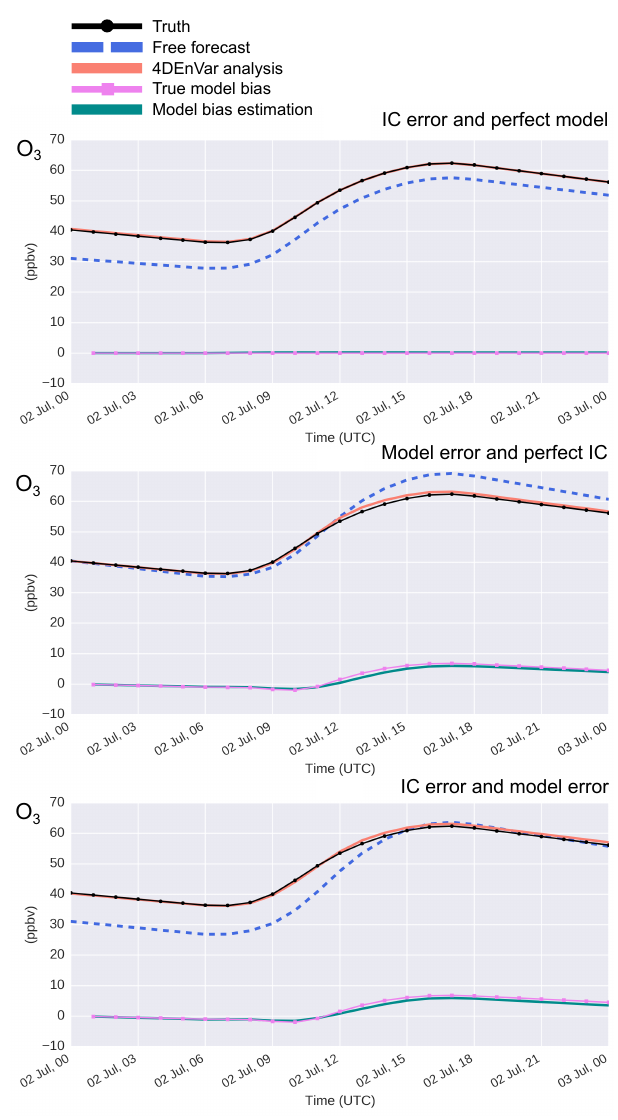
Figure 8. O 3 effective model error estimation in the univariate case (only O 3 assimilated). Temporal trajectories during day 2 for the forecast, the analysis, the truth, the true effective model error and the effective model error estimated using Eq. (12), for the pixel A located close to an observation. From top to bottom the fol- lowing experiments are shown with the uncertainties being intro- duced: (i) only in the O 3 initial condition (as in Sect. 4.1), (ii) only in the forecast model (through surface emissions perturbation) and (iii) both in the O 3 initial condition and in the forecast model.